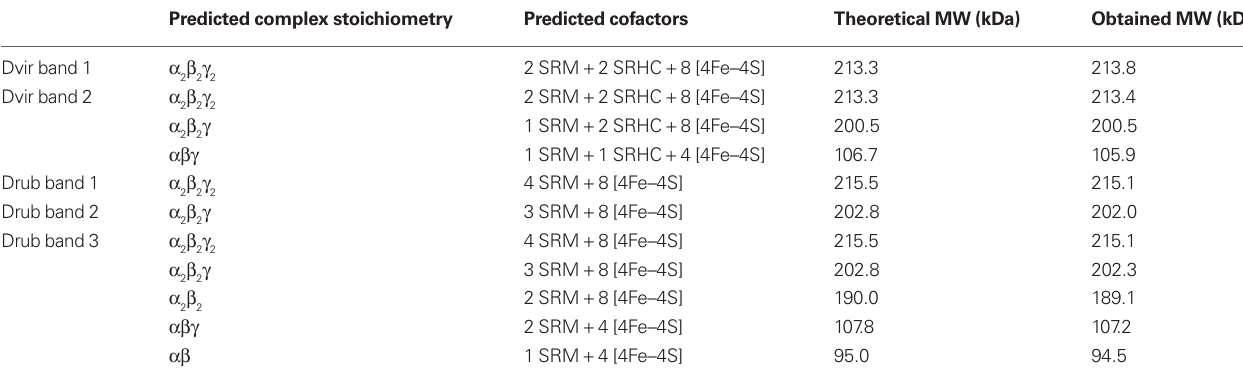
Table 2 | Predicted and observed molecular weight of the different oligomeric forms of D. vulgaris Dvir and D. norvegicum Drub. Predicted complex